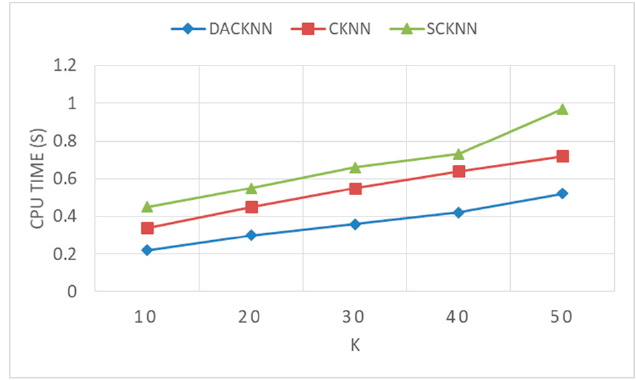
Figure 19. Time consumption of Algorithms for different K values. ISPRS Int. J. Geo-Inf. 2019 , 8 , x FOR PEER REVIEW